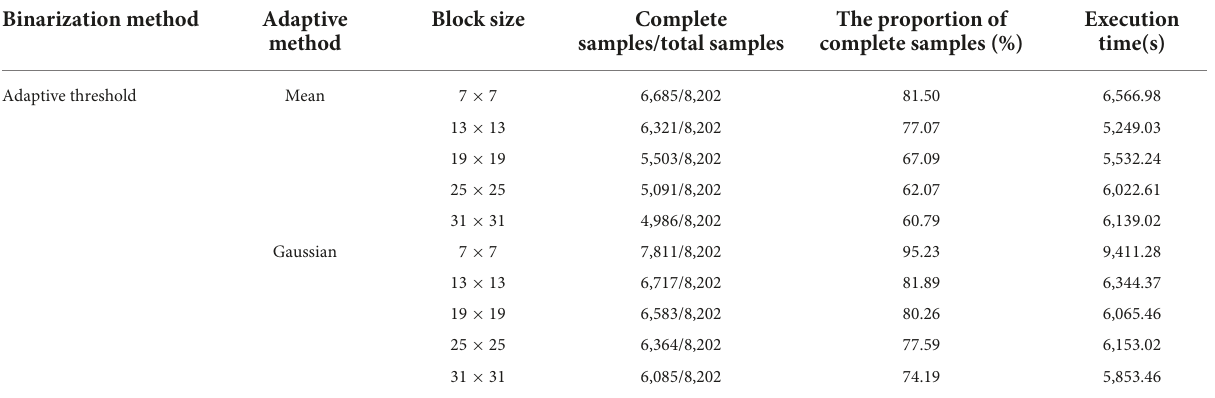
TABLE 2 Adaptive threshold binarization performance evaluation table.